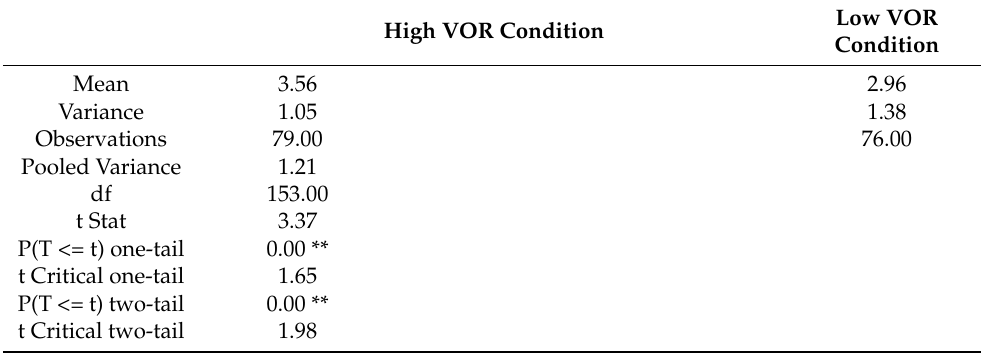
Table 10. Study 2b Independent Sample t